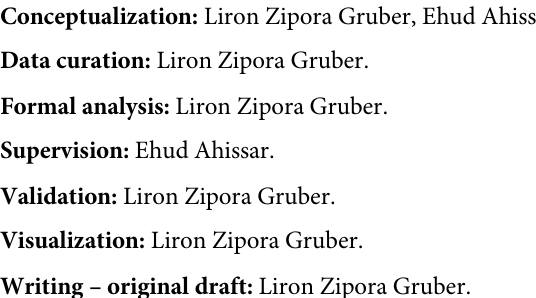
S1 Fig. Saccades direction following border scanning. Related to Fig 1B and 1C. Distribu- tions of the angles between the orientation of the border scanned during a pause and the direc- tion of the immediately following saccade [data shown in purple, shuffled data ( saccade directions were shuffled before angle computation; average of 100 repetitions is depicted) in gray]. Data for each is presented. All distributions are statistically different, p < 0.05, two-sam- ple Kolmogorov-Smirnov tests. S2 Fig. Dependencies between kinematic variables. Related to Fig 3. (a) The mean amplitude of the preceding saccades of all pauses in each of the four experimental conditions; no signifi- cant difference was found (p > 0.1, two-tailed t-test); similarly, no significant difference was found for the maximal saccade speed (p > 0.1, two-tailed t-test). (b-d) Each data point repre- sents a single pause (mean pause speed versus (b) the amplitude of the preceding saccade , (c) the maximal speed of the preceding saccade (d) mean pupil size during the pause). R 2 < 0.01 in all cases. Colors as in Fig 3. (e) Mean within-pause instantaneous pupil size (f) Mean within-pause instantaneous drift speed (no correlation with the mean within-pause instanta- neous pupil size, R 2 = 0.02, p = 0.55) (g) Lower bound of the mean within-trial instantaneous drift speed, calculated from the filtered data (a third order Savitzky-Golay filter with window size of 3 samples [45]). S3 Fig. Stability of instantaneous drift speed convergence. Related to Fig 3. (a) Mean within- pause instantaneous drift speeds presented for large (left) and small (right) objects, depicted for 0 < t < 100 ms from pause onset (colors as in Fig 3). Error-bars denote SEMs across pauses. Light colors show individual means per subject. (b) same as (a) for 0 < t < 400